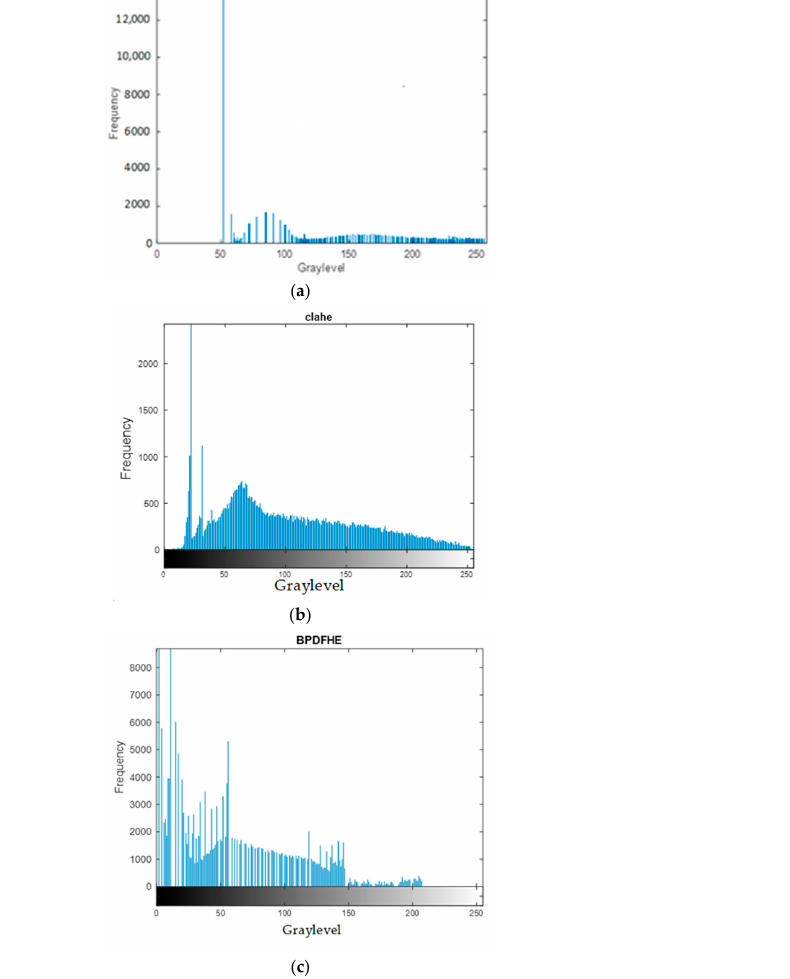
values. On average, the MSE value lowered by 63.21% from HE to CLAHE, dropped to 97.55% from HE to BPDFHE, and decreased by 94.75% from CLAHE to BPDFHE. The